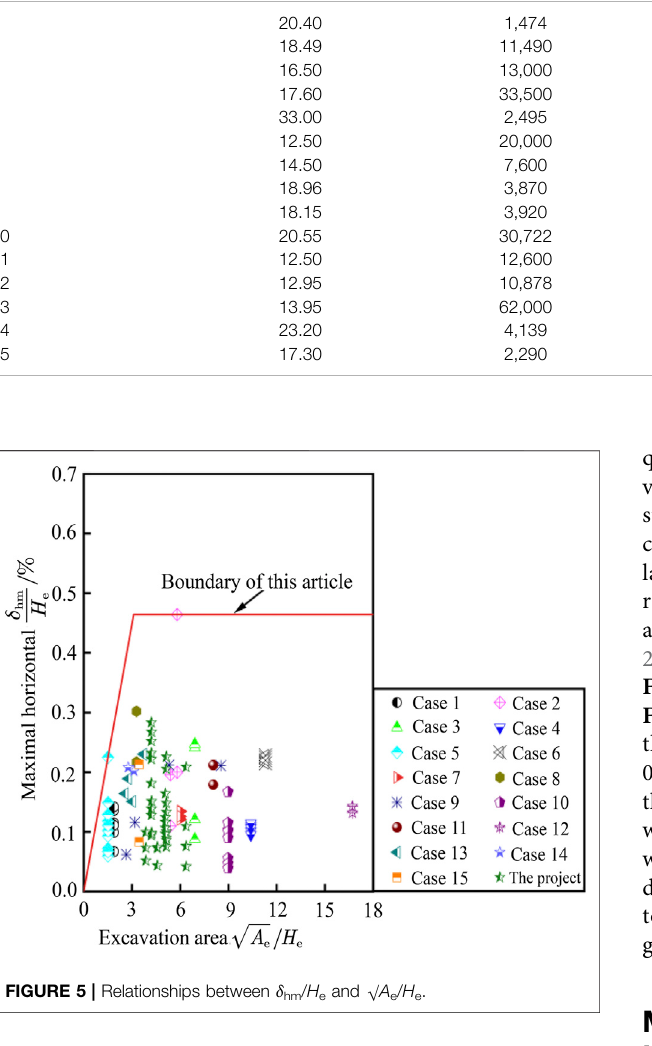
Frontiers in Earth Science |